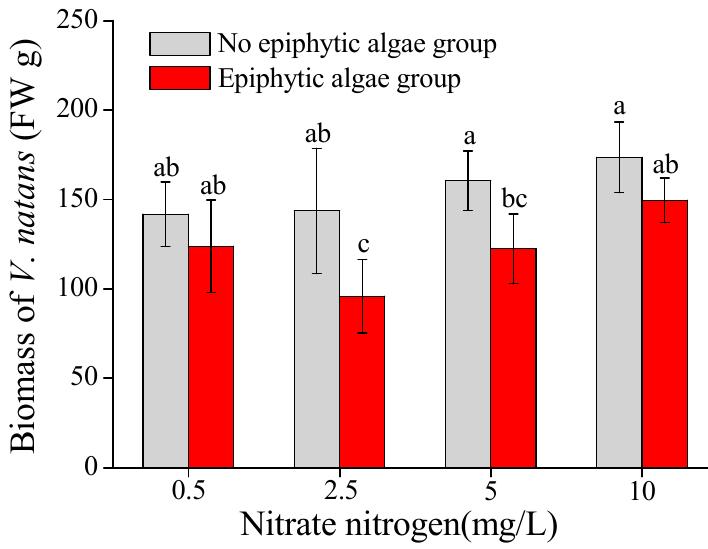
Figure 1. Biomass of V. natans (mean ± SE, n = 3) in the epiphytic algae group and no epiphytic algae group under four nitrate-N concentrations. Bars with different letters indicate significant differences among treatments ( p < 0.05).